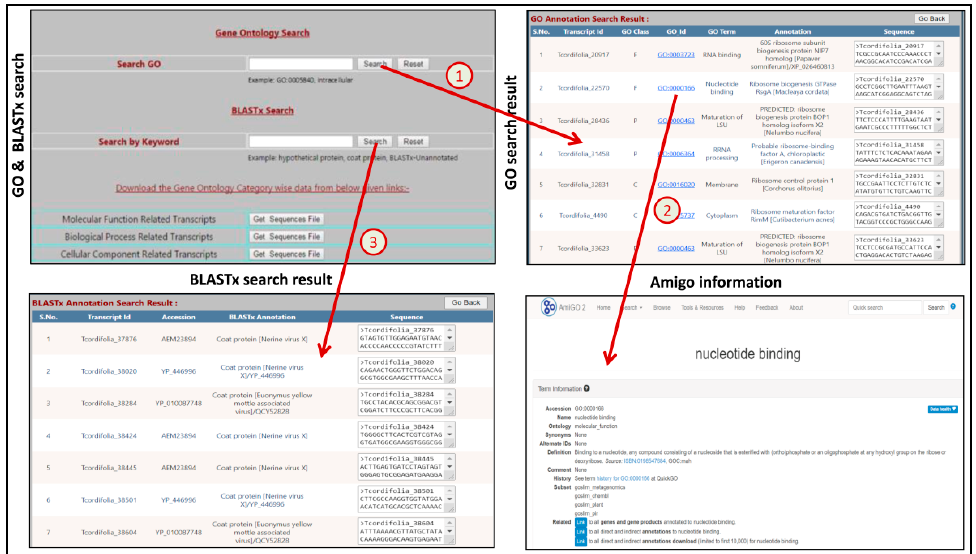
Figure 7. Screenshot of the TinoTranscriptDB showing transcript annotation searching with the download option for several sequences, (1) arrow shows Gene ontology search by the GO Id; (2) arrow shows by click on the particular GO Id detailed information on a separate page; (3) arrow shows BLASTX search by the annotation keyword on a separate